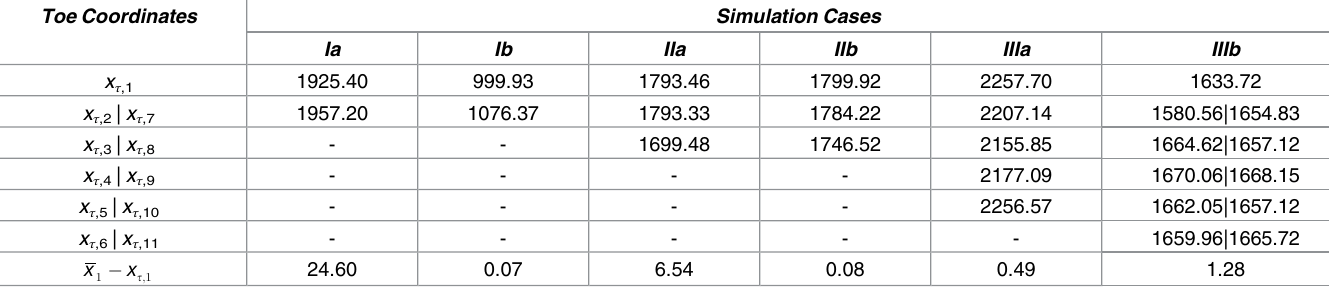
Table 7. Coordinates x τ ( meters ) of the toe critical points for all simulation cases. Toe Coordinates Simulation Cases